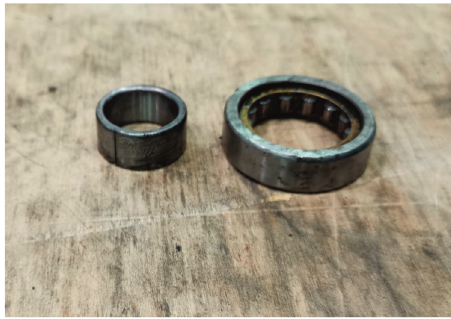
Figure 12: Inner ring fault bearing used in the experiment.